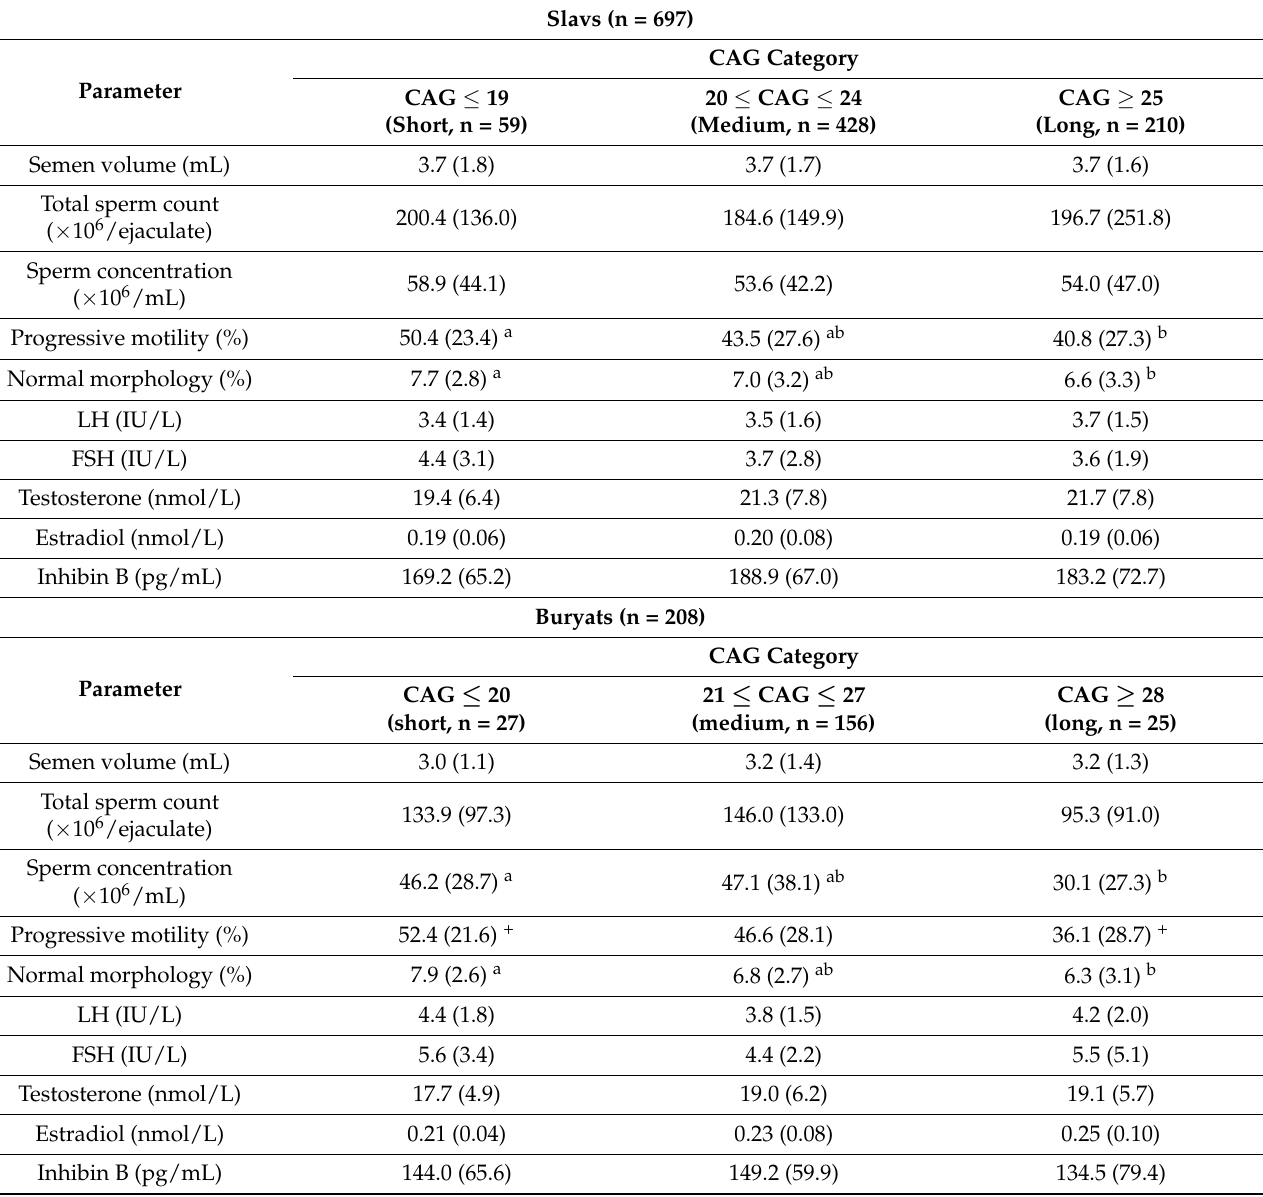
Table 5. Comparison of semen and hormonal parameters between different CAG categories in the Slavic, Buryat and Yakut ethnic